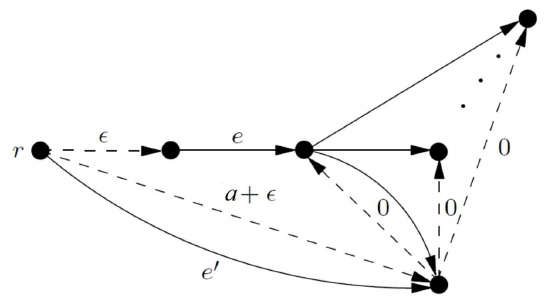
Figure 4. An example where the single-price algorithm, i.e., the algorithm that eventually will price all the edges with a same value σ ≥ 0, does not return a better than ( n − 3 ) -approximate solution. Dashed edges are fixed-cost edges, while the other edges are owned by the leader. Pricing e with 0, e (cid:48) with a + (cid:101) , and all the other edges with a yields a revenue of a ( n − 3 ) . On the other hand, pricing all edges with any value 0 ≤ σ ≤ a + (cid:101) yields a revenue of only σ . Notice that the running time of the single-price algorithm depends on log a , and thus is not polynomial in a strong